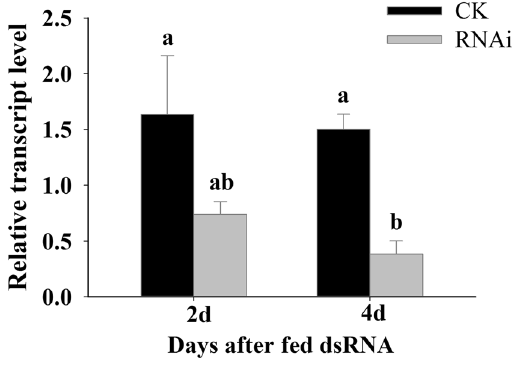
Figure 6. Transcript levels of B. tabaci LAC1 after dsRNA feeding. Values are represented as the mean ± SEM. The letters above the columns indicate the comparison among groups evaluated by an ANOVA using SAS 8.1, p <